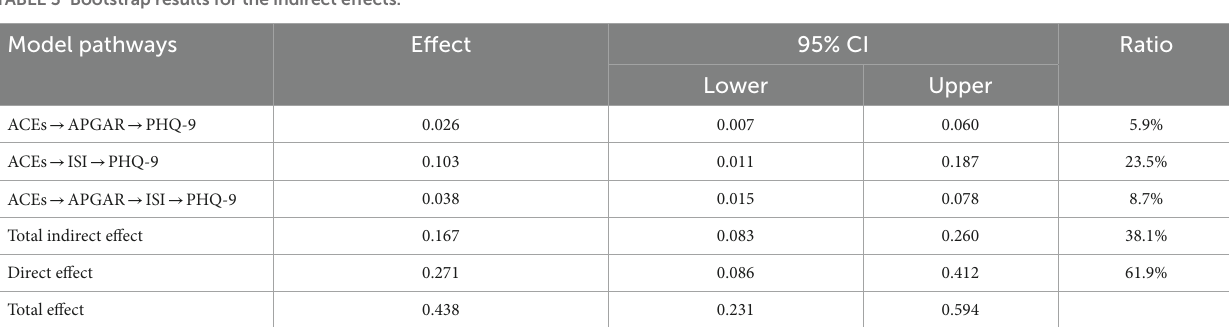
TABLE 3 Bootstrap results for the indirect effects. Model